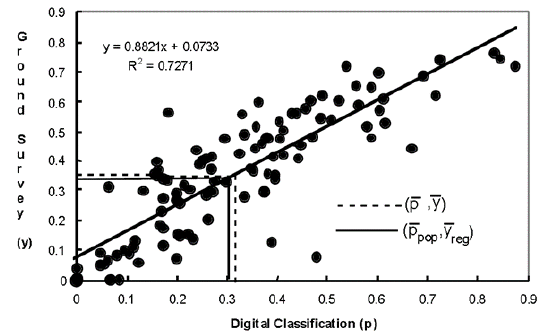
Figure 4: Relationship between digital classification and ground survey for wheat in the UK (after (Taylor,